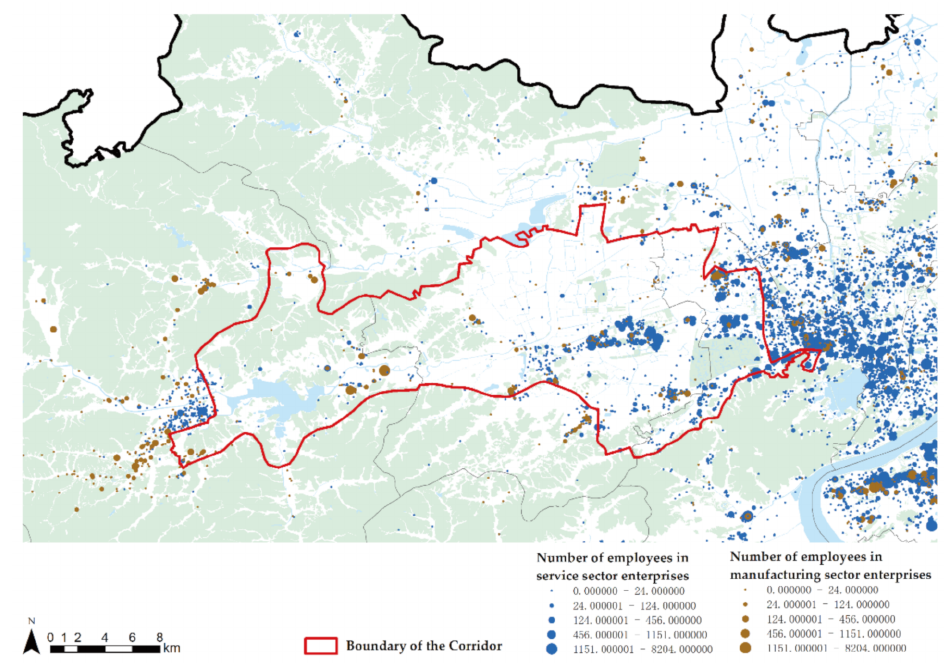
Figure 4. Spatial distribution of